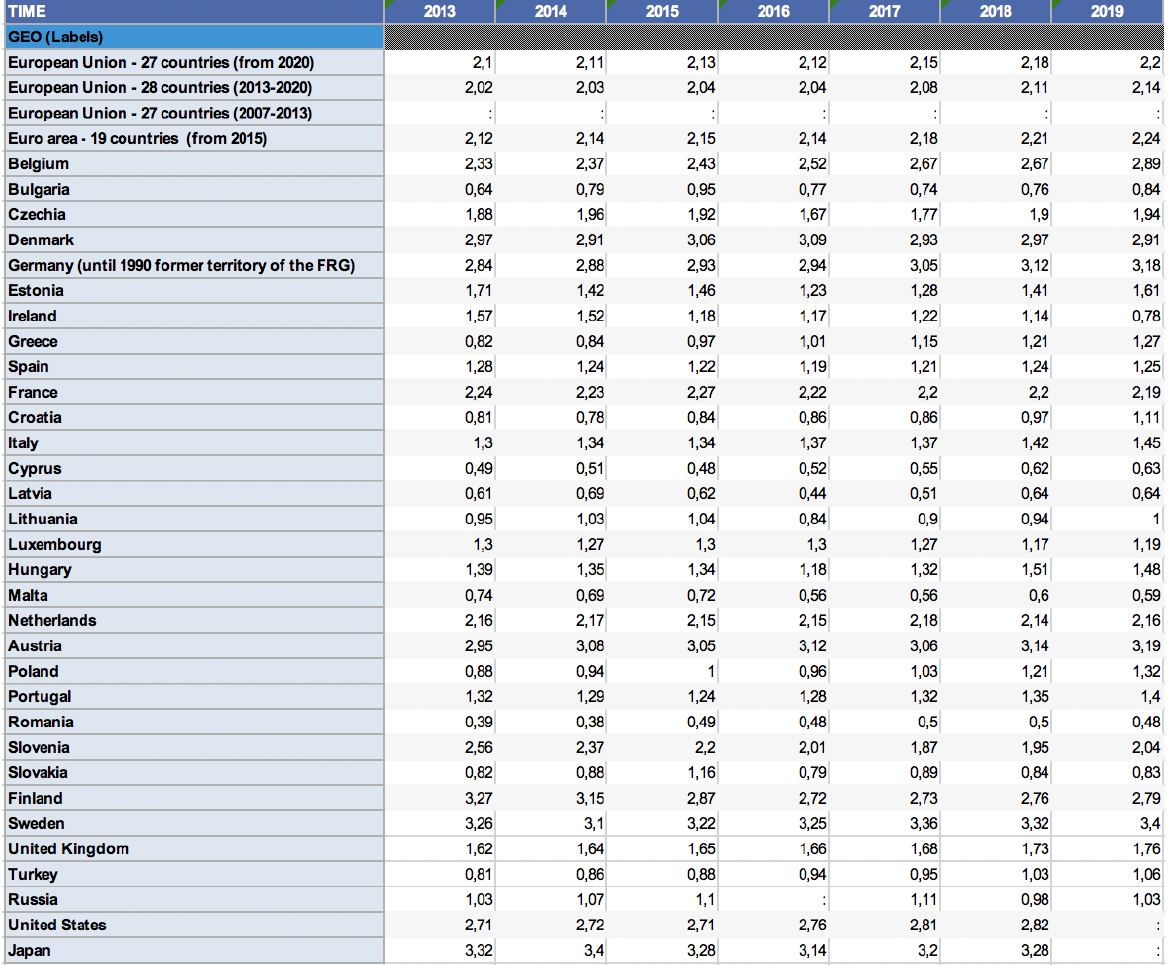
Figure 5: Gross Domestic Expenditure on R&D (2013-2019) (Source: Eurostat